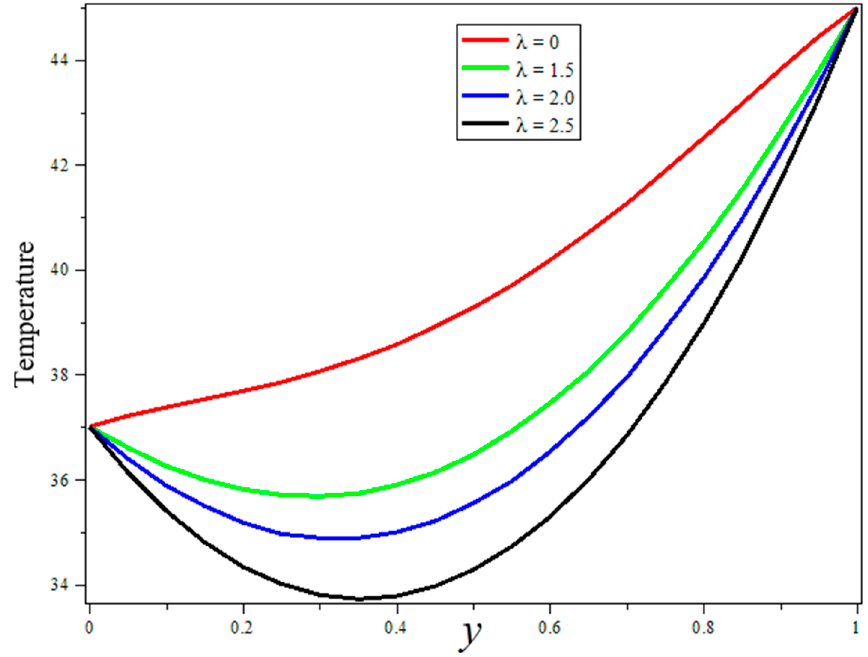
Fractal Fract. 2022 , 6 , x FOR PEER REVIEW Figure 2. The impact of vascularization on the temperature field during hyperthermia tumor treatment.